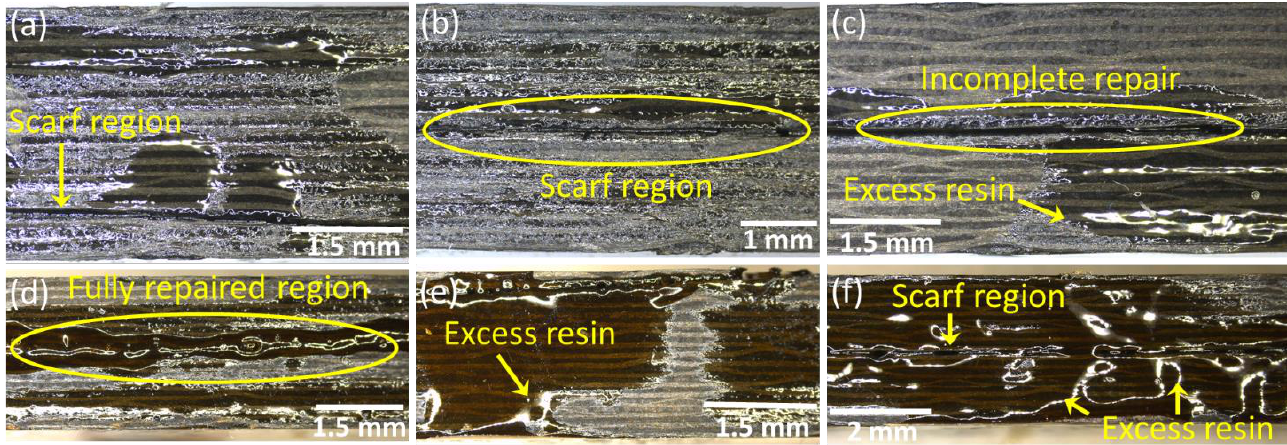
Figure 5. Optical micrographs of the specimens ( a – c ) repaired at room temperature and ( d – f ) repaired at 210 °C.